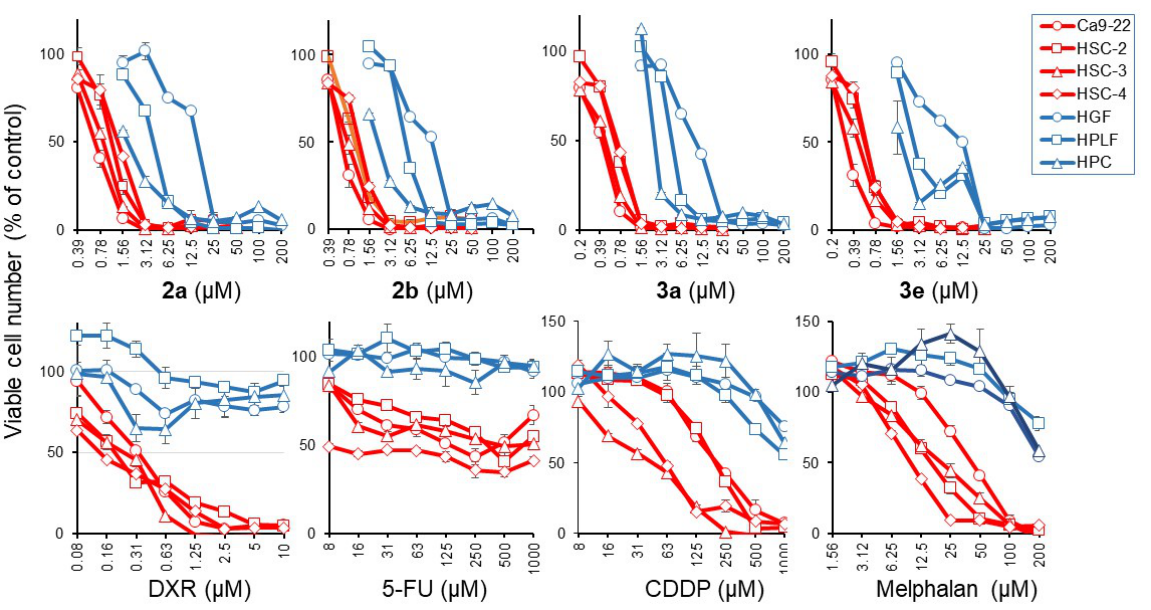
Figure 4. Dose–response curve of the cytotoxicity of 2a , 2b , 3a , 3e , and anticancer drugs. Cells were incubated for 48 h without (control) or the indicated concentrations of test samples, and the viable cell number was determined by the MTT method and expressed as % of control. Each value is represented as the mean ± S.D. of triplicate determinations.